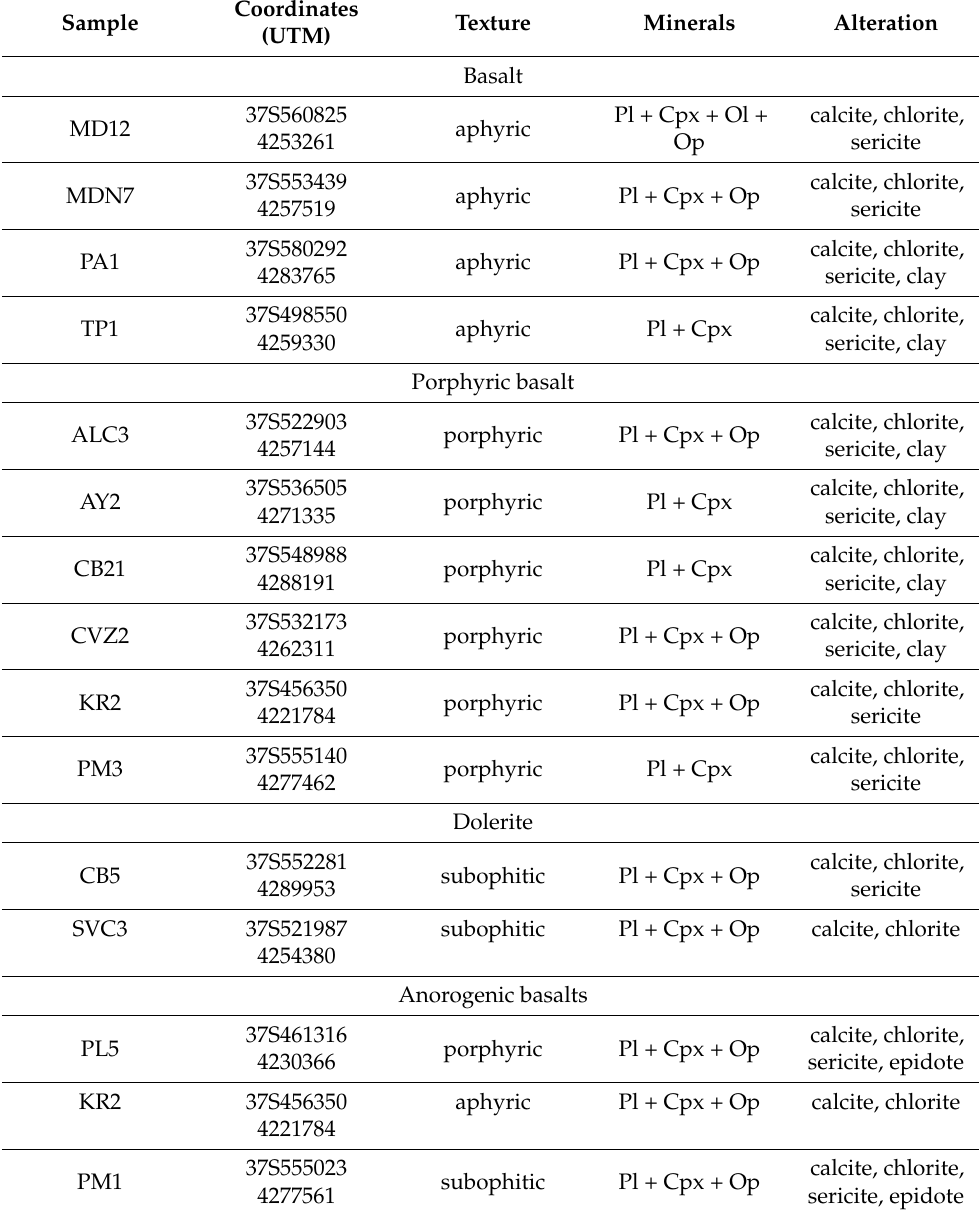
Table 2. Microtextural features and mineralogic constituents of the different basic rocks from the Yüksekova Complex (E